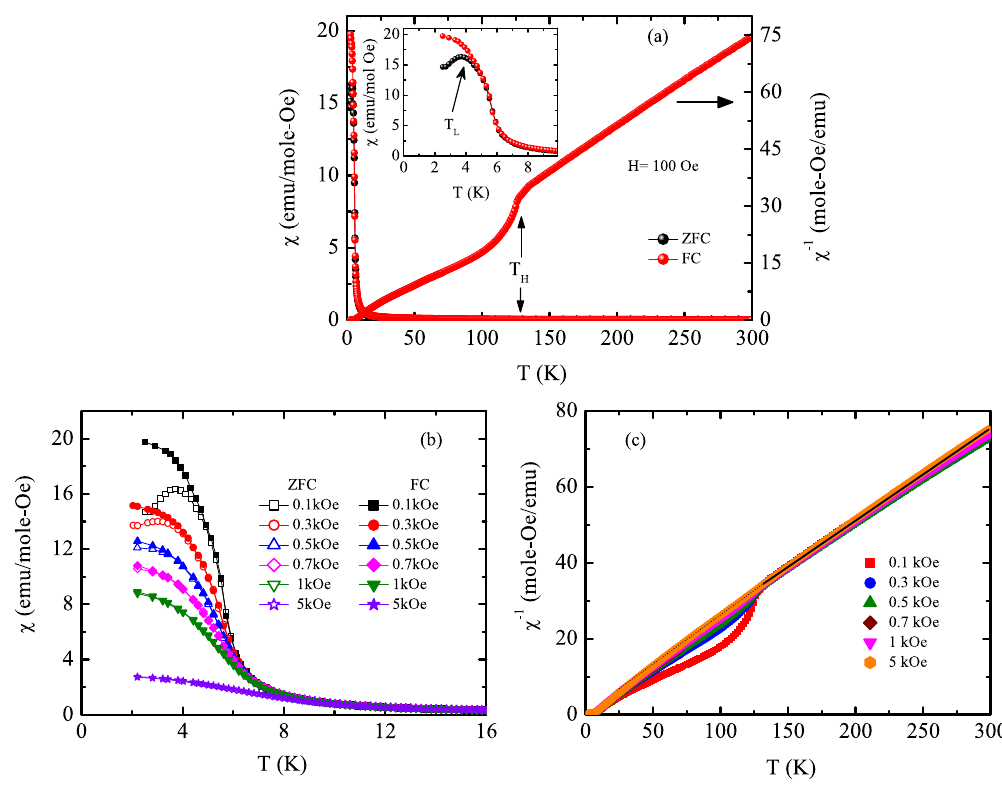
Figure 7. (a) χ( T ) in ZFC and FC protocol (left panel) and χ − 1 ( T ) in FC protocol (right panel) for H = 0.1kOe . Inset shows the expanded low-temperature region. (b) χ( T ) and (c) χ − 1 ( T ) measured at various applied magnetic